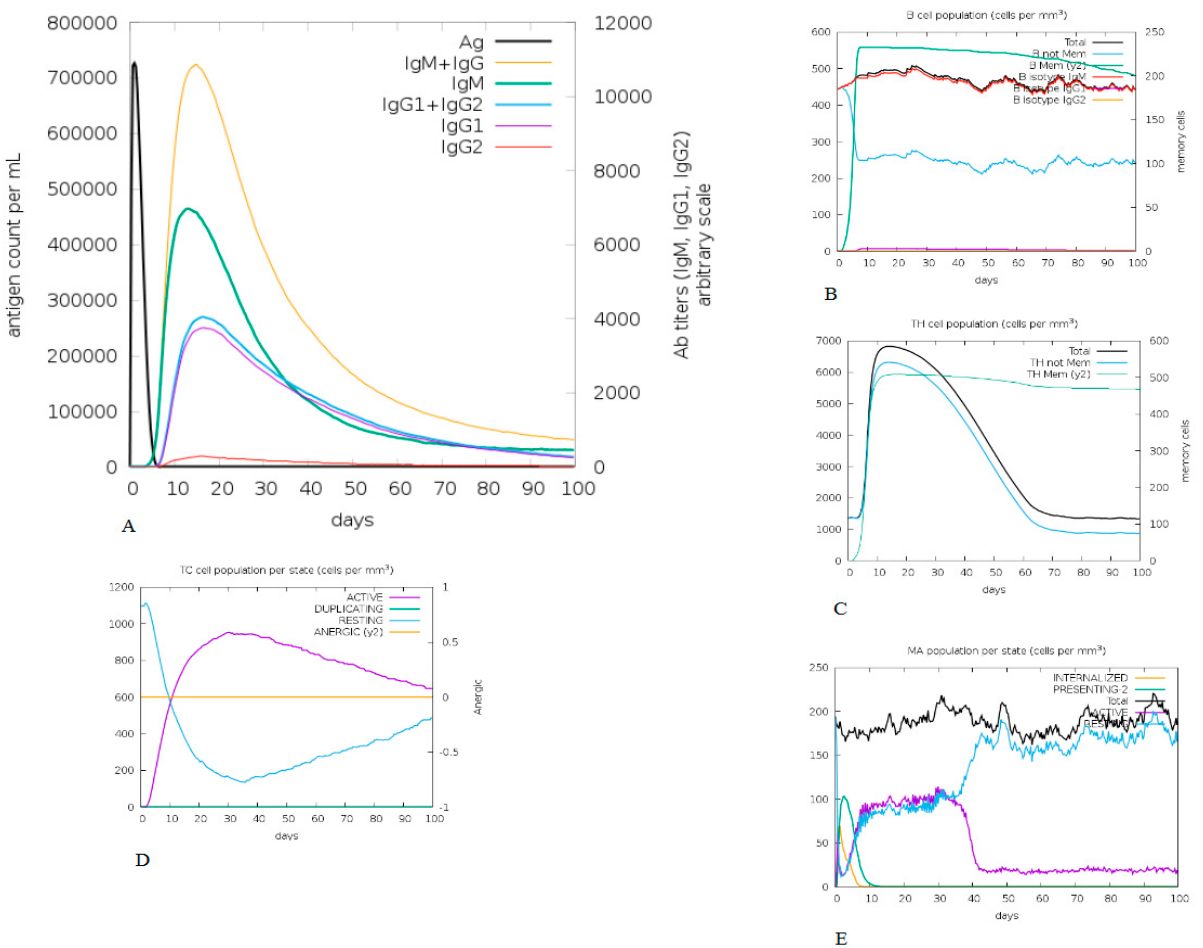
Figure 5. Immune simulation profile of constructed vaccine. ( A ) Exhibits both the relative antibody responses and antigen concentration and the presence of protective IgGs indicates that the vaccination was effective. ( B ) Depicts the relevant number of antibody-producing plasma cells. ( C – E ) Presents the activity of macrophages cytotoxic T and helper T cells.